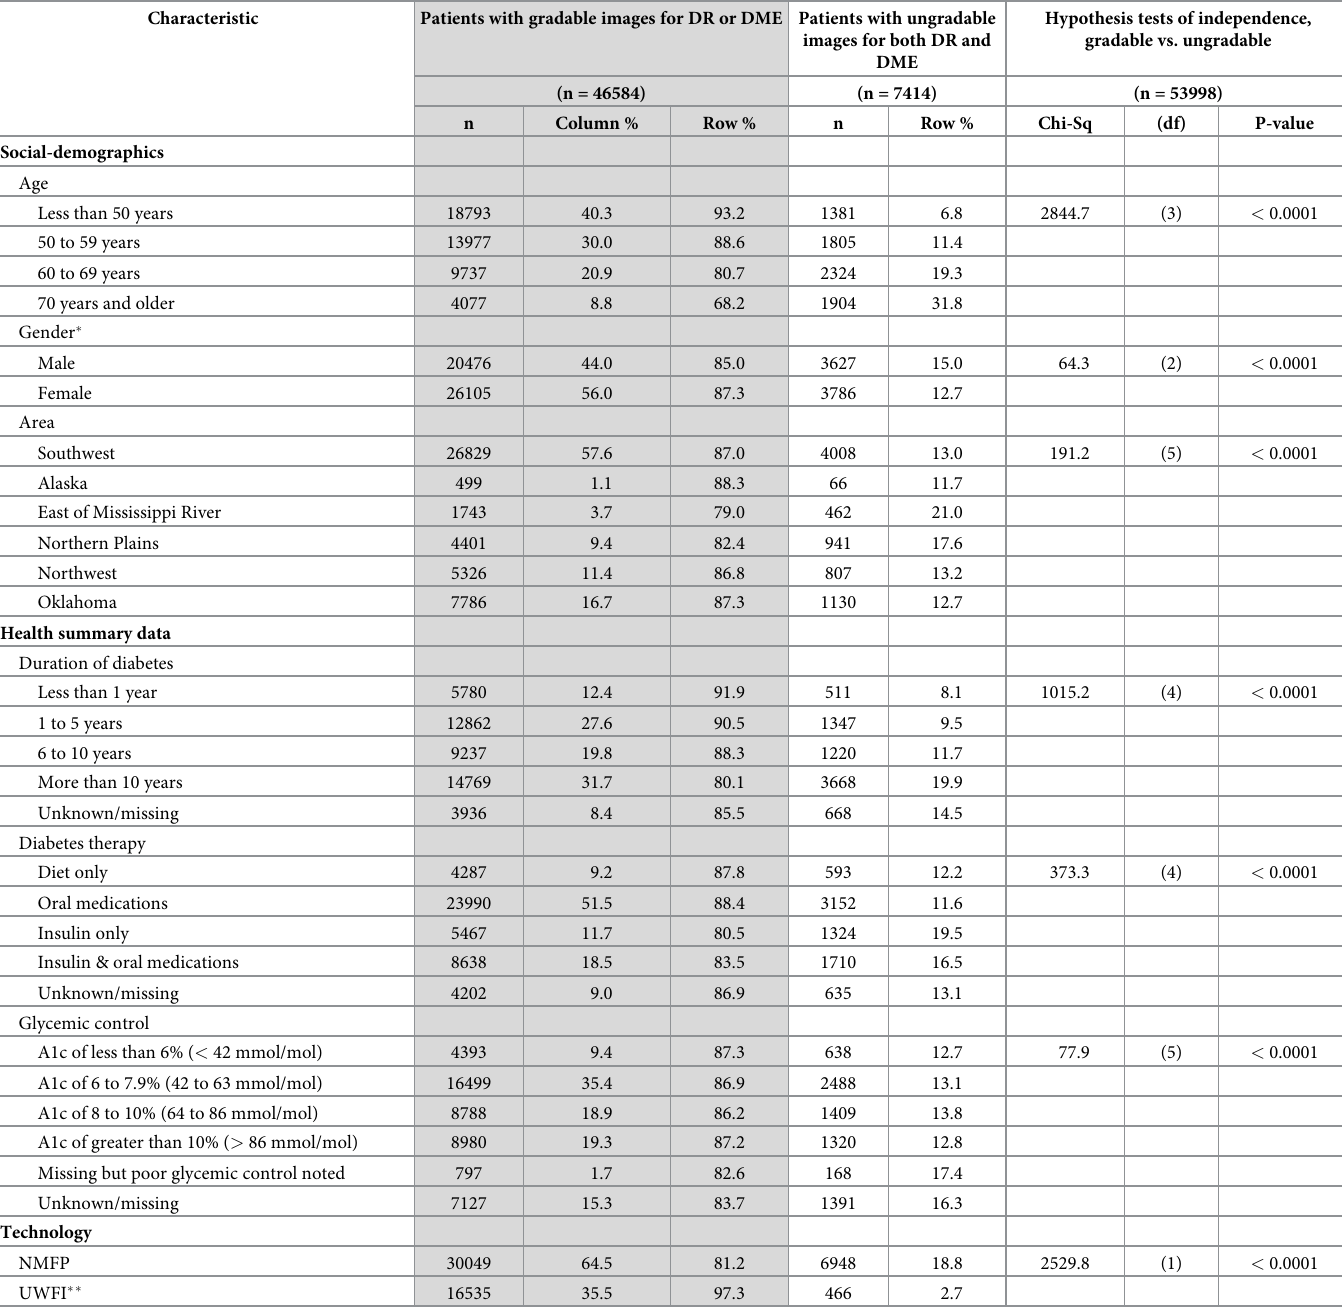
Column percentages are shown to characterize the analytic sample, patients with gradable images only. Row percentages are shown to examine differences in the likelihood of having gradable images, based on patient